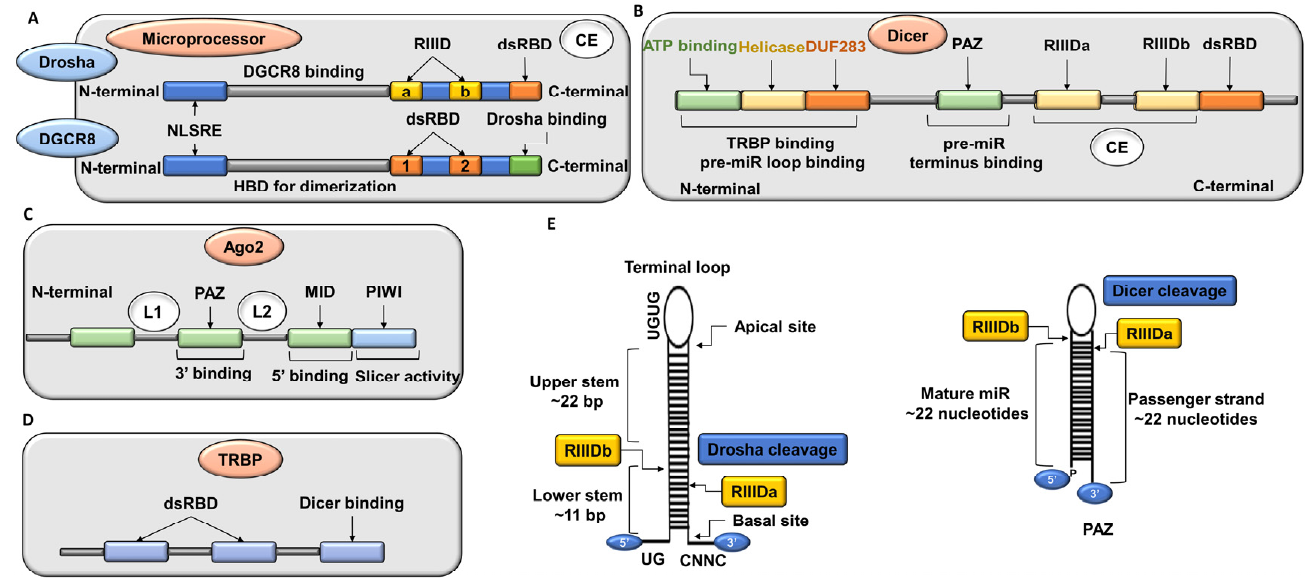
Figure 3. Arrangement of domains of ( A ) microprocessor (Drosha and DGCR8 complex), ( B ) Dicer, ( C ) Ago2, and ( D ) TRBP in humans. ( E ) Recognition and processing of substrate by Drosha/DGCR8 complex and Dicer (refer to Sections 2.1 and 2.2). CE: catalytic end, HBD: heme-binding domain, L: linker.